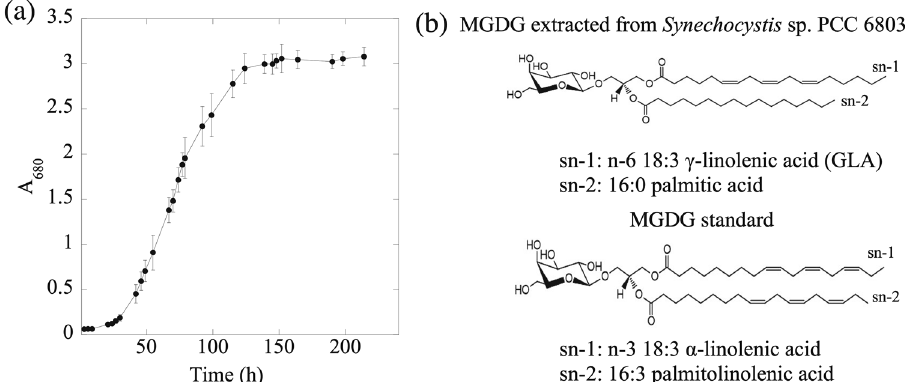
Figure 2. The growth kinetics of Synechocystis sp. and structure of MGDG. ( a ) Growth curve of Synechocystis sp. PCC 6803 wild type strain. The growth was measured in terms of absorbance value obtained at 680 nm. ( b ) Structure of MGDG extracted from Synechocystis sp. PCC 6803 containing n-6 18:3 γ-linolenic acid (n-6 GLA) and 16:0 palmitic acid at sn-1 and sn-2 fatty acid chains, respectively (upper panel); the most abundant structure of plant extracted MGDG standard containing n-3 18:3 α-linolenic acid (n-3 ALA) and 16:3 palmitolinolenic acid at sn-1 and sn-2 fatty acid chains, respectively (lower